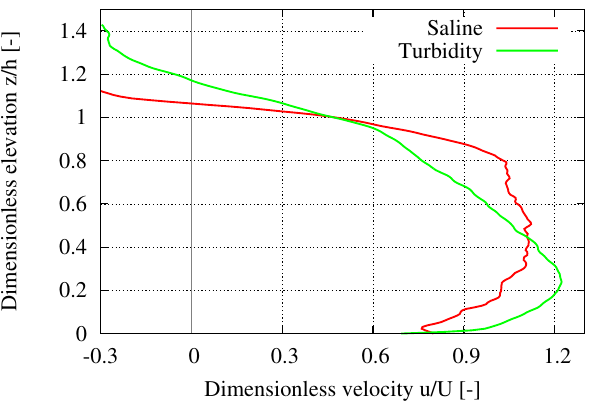
Figure 12. Comparison between a saline density current (experi- ment S14) and a turbidity current (experiment S25) with suspended sediment performed under the same conditions ( q 0 = 0 . 0069m 2 s − 1 and ∆ ρ/ρ 0 = 0 . 6 %), measured in cross section C5.